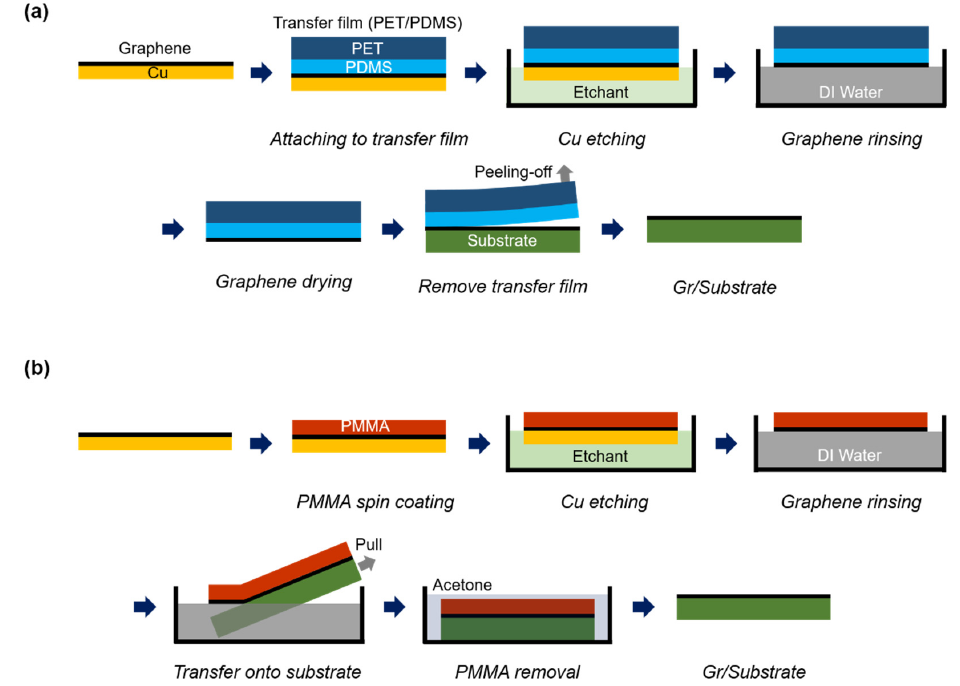
Figure 1. Schematic diagram of the transfer processes of chemical vapor deposition-grown graphene (Gr) on copper foil (Cu): ( a ) dry transfer and ( b ) wet transfer. PDMS: polydimethylsiloxane; PMMA: poly(methyl methacrylate); DI water: deionized water.